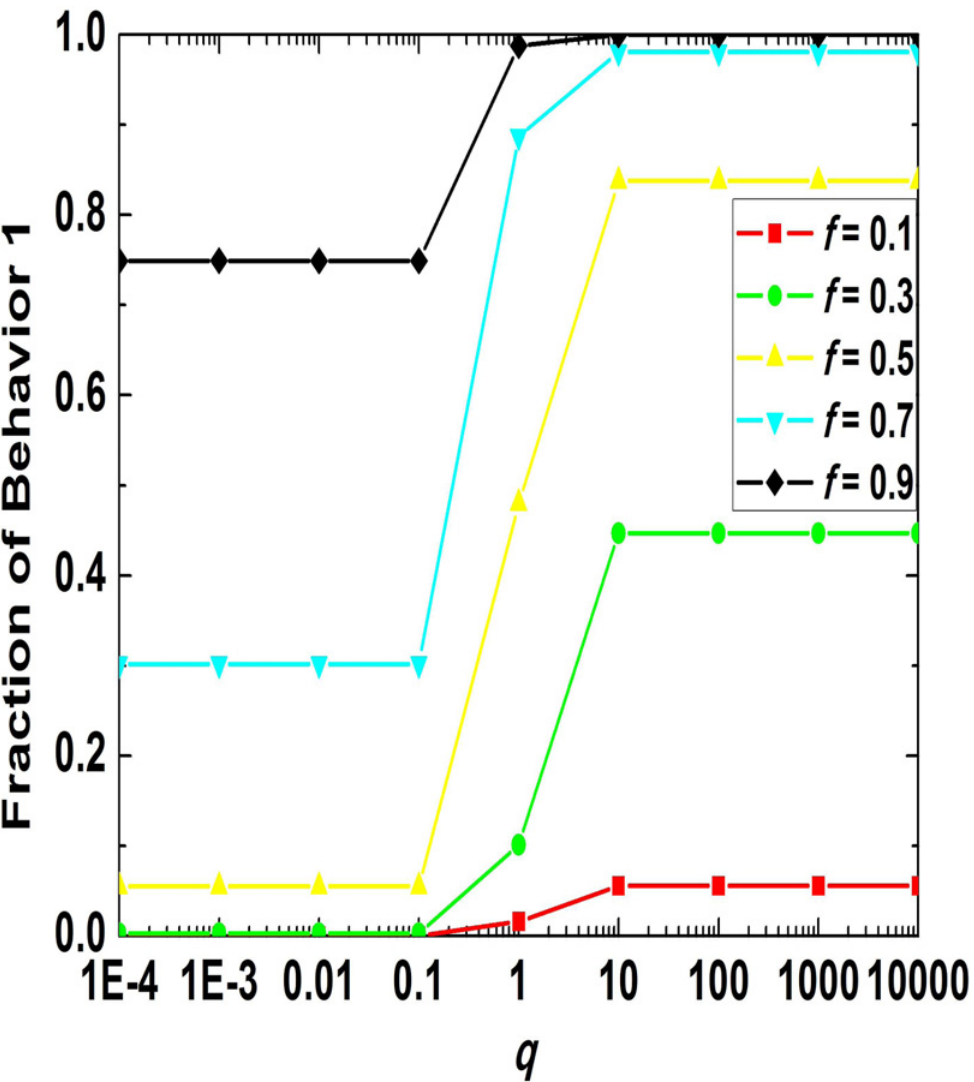
Fig 6. Relationship between the fraction of behavior 1 in population and RDP for small group 1. In the numerical simulations corresponding to the figure, the payoff parameters adopted are specified as [ B 1 , B 2 , B 3 , B 4 , C 1 , C 3 ] = [2, 2, – 1, – 1, 1, 2], C 2 = C 1 / q , C 4 = C 3 / q